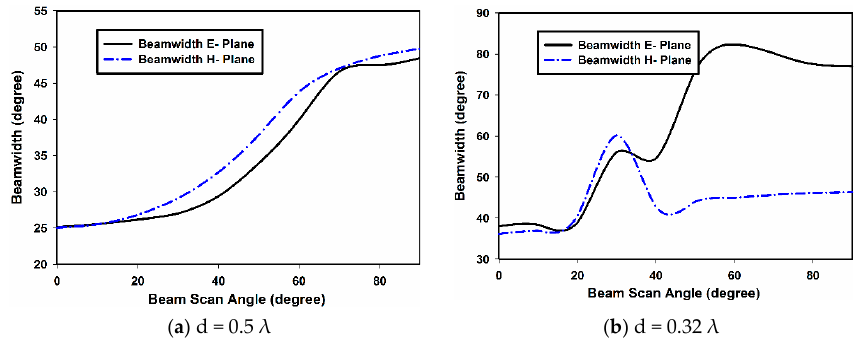
is 8.5 dBi and reaches 8.8 dBi when the main beam is pointing in θ = 90°. It can be